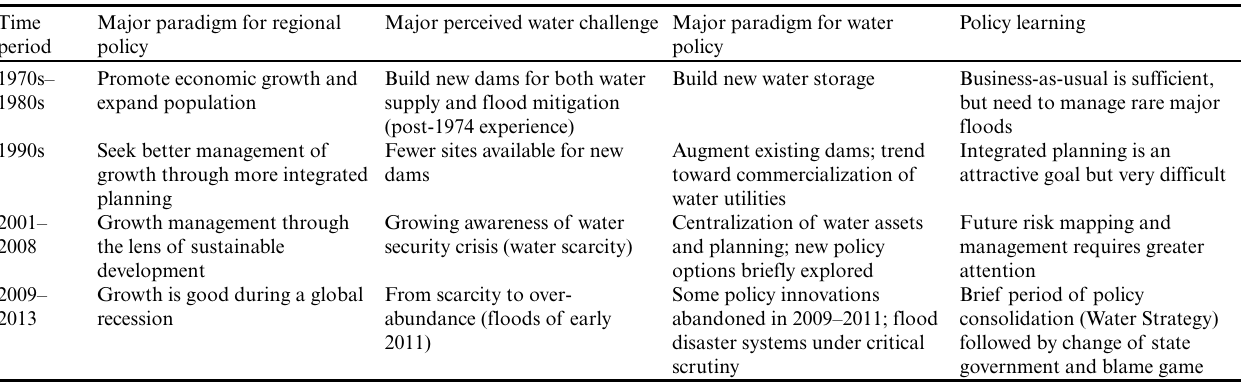
Table 3. Changing frameworks in the urban water sector, Southeast Queensland, Australia, since the